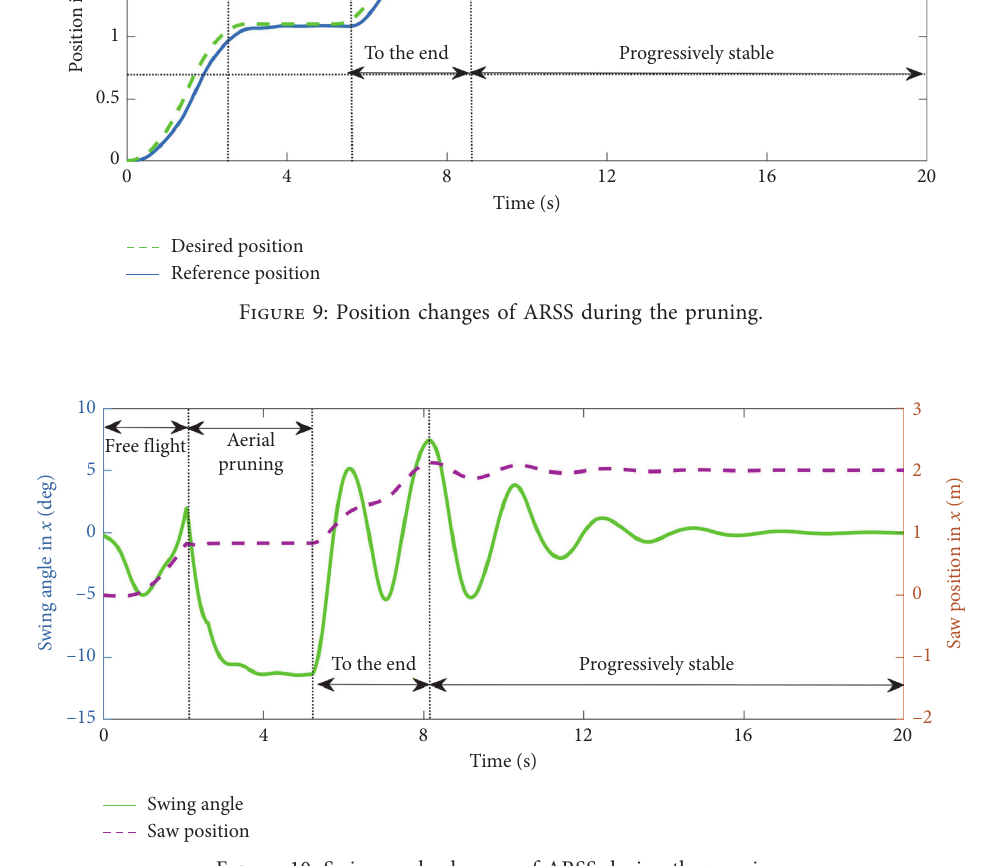
Figure 10: Swing angle changes of ARSS during the